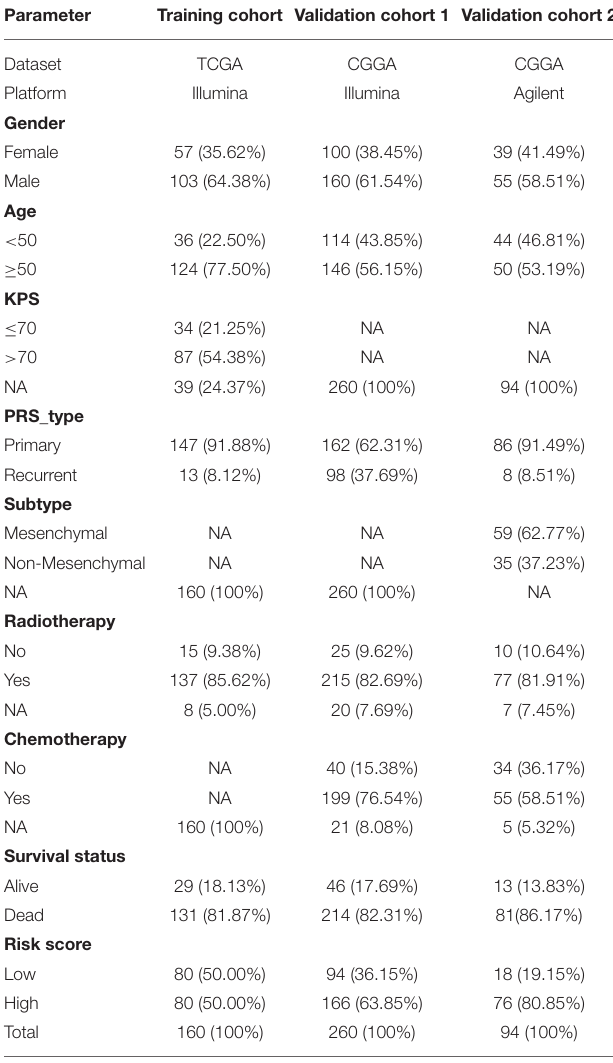
TABLE 1 | The baseline characteristics of patients with glioblastoma (GBM) in this study. Parameter